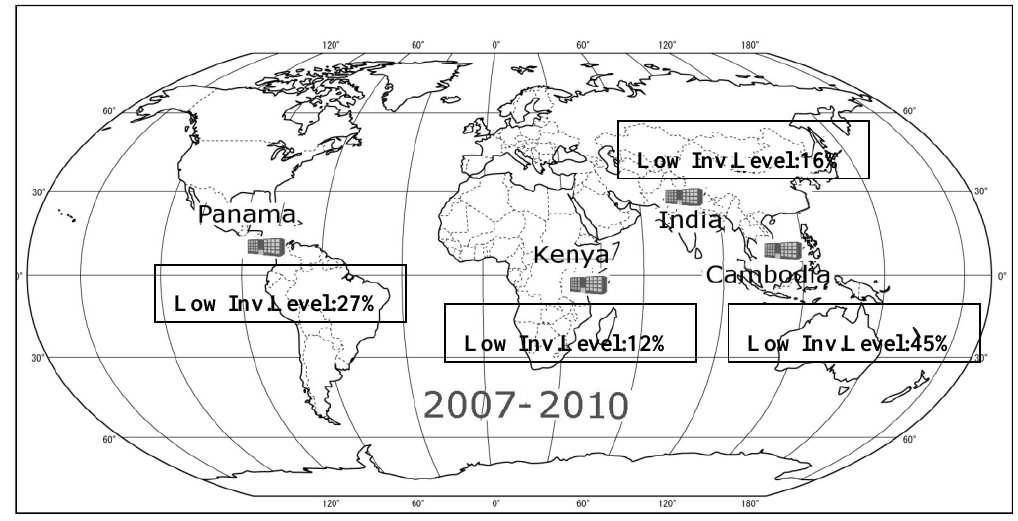
Figure 5. Optimal four warehouse network with inventory dispersion calculated from 2007–2010 time